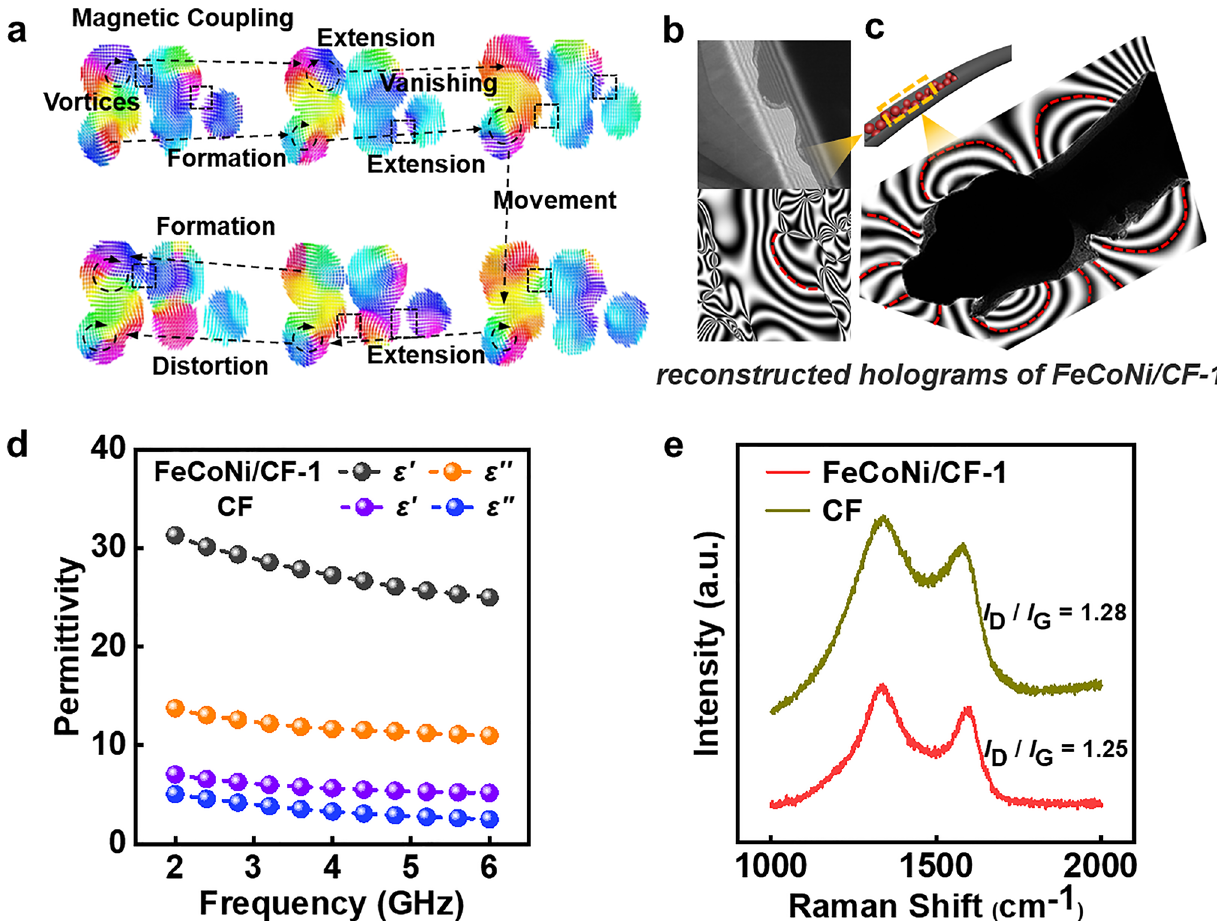
Fig. 4 a Micromagnetic simulation of 1D axially distributed FeCoNi NP (The external magnetic field frequency is 6 GHz, and the diameter of the microsphere is 200 nm). b Electron holograms of FeCoNi/CF-1 and corresponding stray magnetic field distribution. c TEM image of FeCoNi/CF-1 and the corresponding stray magnetic field distribution with recombination of different regions. d Permittivity of FeCoNi/CF-1 and CF. e Raman spectra of FeCoNi/CF-1 and